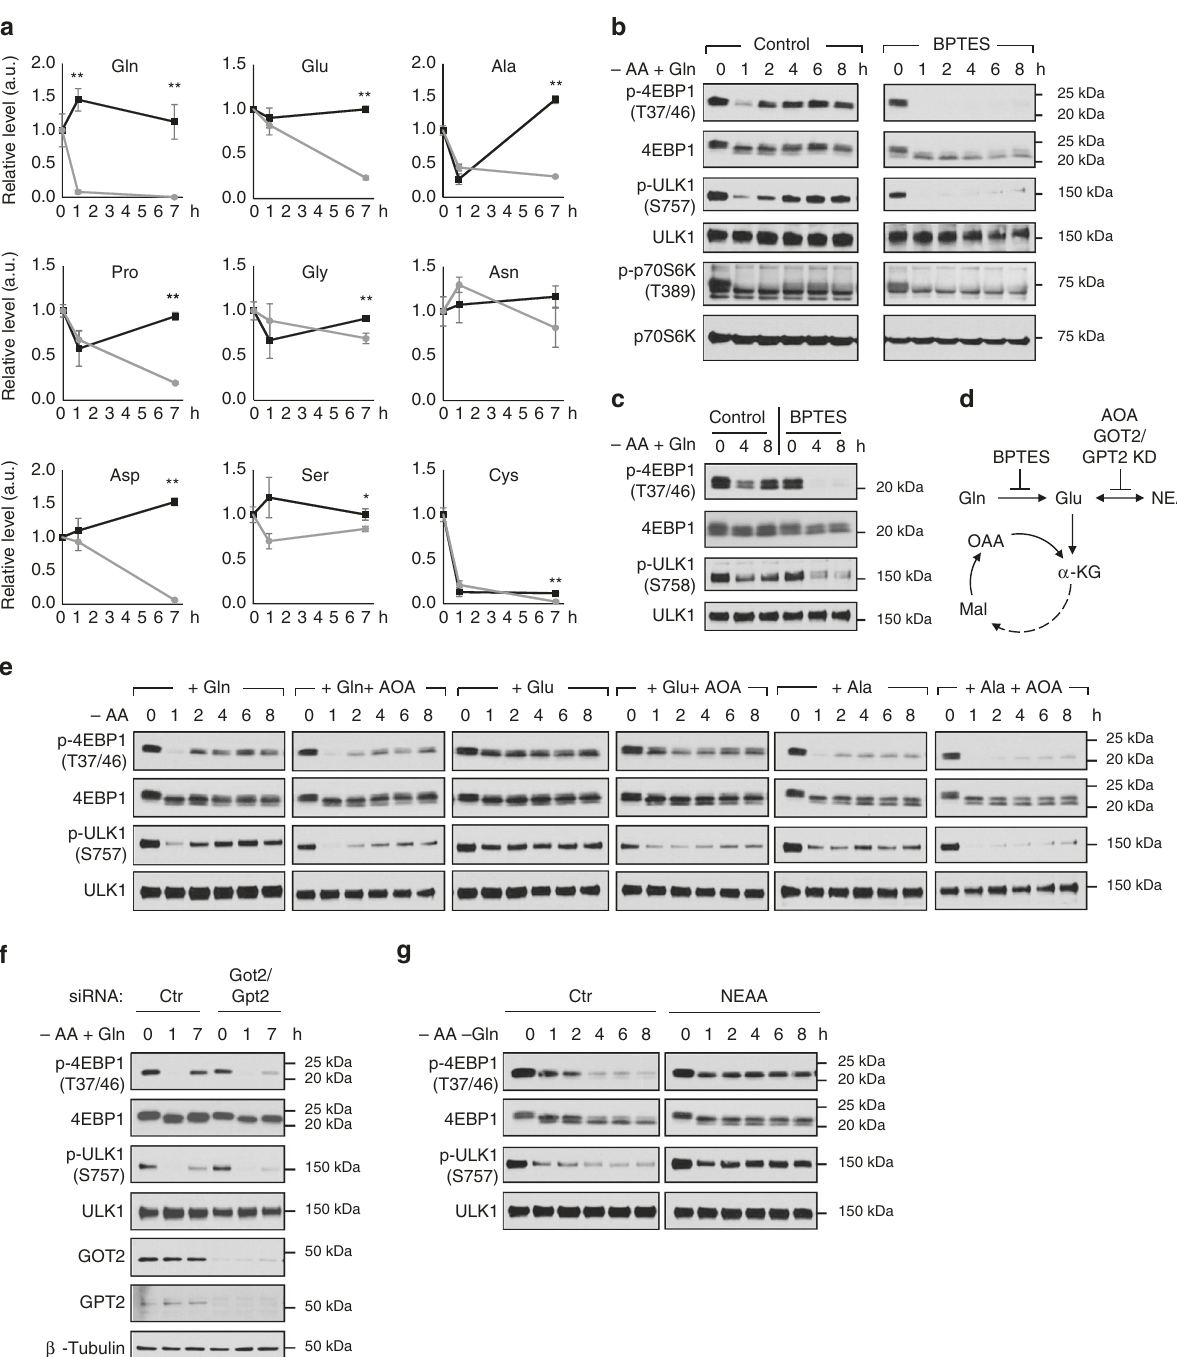
Fig. 3 Glutamine metabolism is essential for mTORC1 reactivation during amino acid starvation. a Wild-type MEFs were starved of amino acids with ( black line ) or without ( gray line ) the supplementation of glutamine (4 mM) for the indicated durations. Individual non-essential amino acid (NEAA) levels were measured from cell lysates by GC-TOF-MS. Data are expressed as the fold change of control cells (unstarved control, 0 h). Data are the mean ± SEM of n = 4 – 5, * P ≤ 0.05; ** P ≤ 0.01 (between the groups with and without glutamine supplementation at the same time point via Student ’ s t -test). b Wild-type MEFs or c HepG2 cells were deprived of amino acids with the supplementation of glutamine (4 mM) for the indicated durations in the absence or presence of BPTES (10 µ M). Changes in mTORC1 activity were assessed by immunoblotting of p-4EBP1 and p-ULK1. d Schematic diagram of glutamine metabolism. Glutamine is converted to glutamate by glutaminase, which is inhibited by BPTES. Glutamate undergoes transamination (which is inhibited by amino- oxyacetate, AOA, or knockdown of GOT2/GPT2), to produce non-essential amino acids (NEAA) and α -KG (a TCA cycle intermediate). e Wild-type MEFs were starved of amino acids with the supplementation of 4 mM glutamine, glutamate or alanine in the presence or absence of AOA (5 mM). f Wild-type MEFs were subjected to siRNA-mediated knockdown of GOT2 and GPT2, and cells were deprived of amino acids with the supplementation of glutamine (4 mM) for the indicated durations. g Wild-type MEFs were starved of amino acids with or without the supplementation of NEAA for the indicated durations. Changes in mTORC1 activity were assessed by immunoblotting of p-4EBP1 and